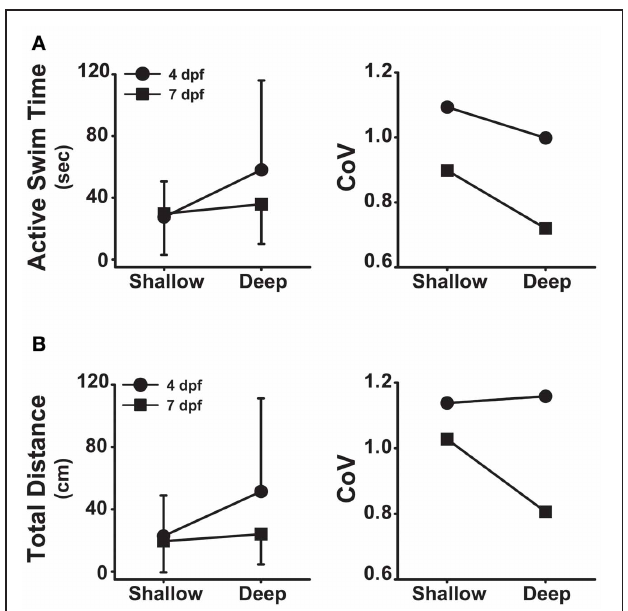
FIGURE 4 | Developmental stage and well depth interact to affect locomotor activity. (A) Left , plot of the interaction between stage and depth for active swim time. Right , plot of the group coefficients of variation for each interaction condition (4dpf × Shallow, n = 41; 4dpf × Deep, n = 51; 7dpf × Shallow, n = 67; 7dpf × Deep, n = 71). (B) Left , plot of the interaction between stage and depth for total distance. Right , plot of the group coefficients of variation (CoV) for each interaction condition (4dpf × Shallow, n = 41; 4dpf × Deep, n = 51; 7dpf × Shallow, n = 67; 7dpf × Deep, n = 71). Measures of active swim time and total distance are expressed as mean ± SD.